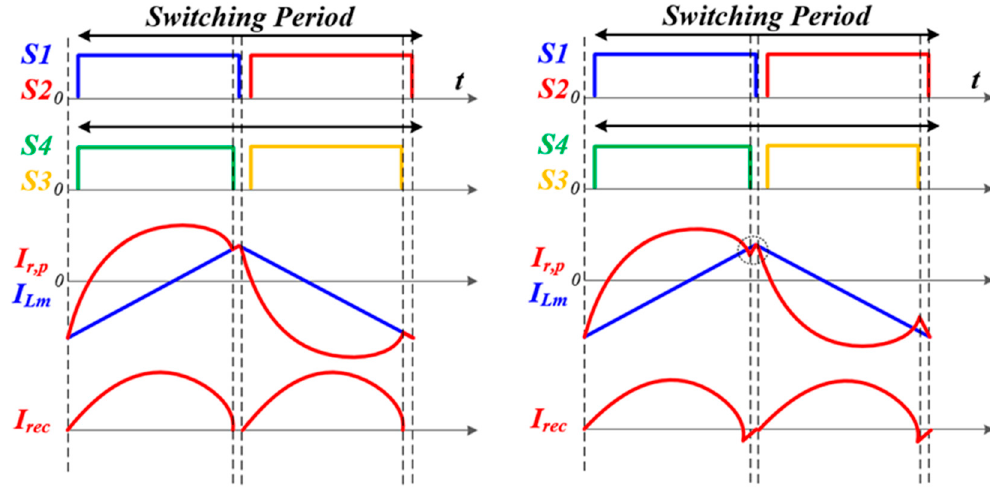
Figure 11. Operating waveforms of synchronous rectification shown in [28].